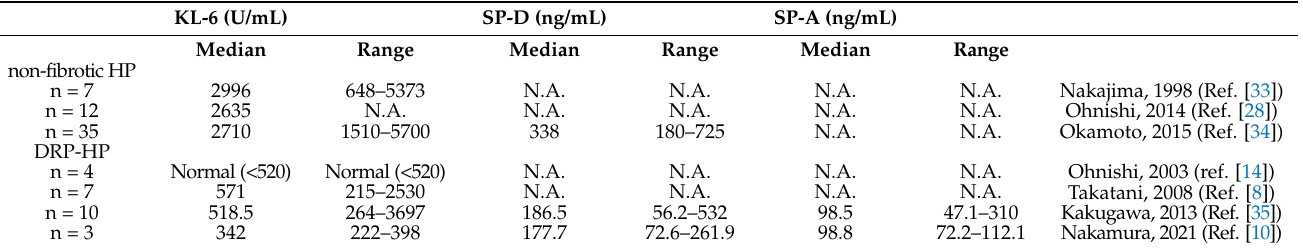
Table 1. Literature review on drug-related pneumonitis with radiologic non-fibrotic HP pattern compared to non-fibrotic hypersensitivity